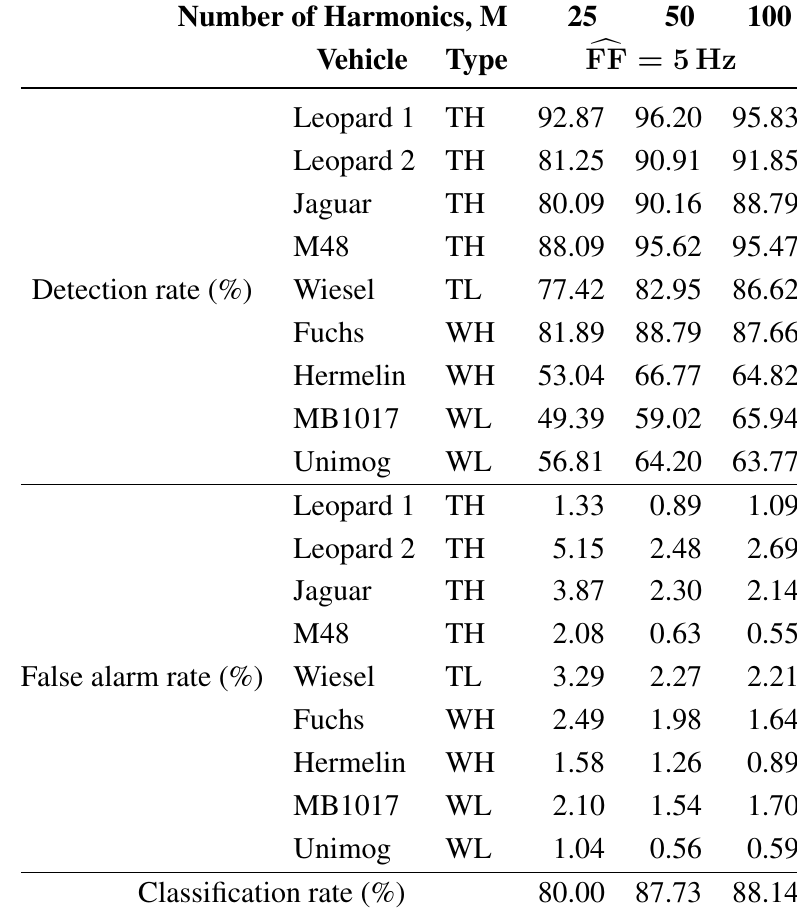
Table 2. Military vehicle single-event detection, false alarm and classification rates, from